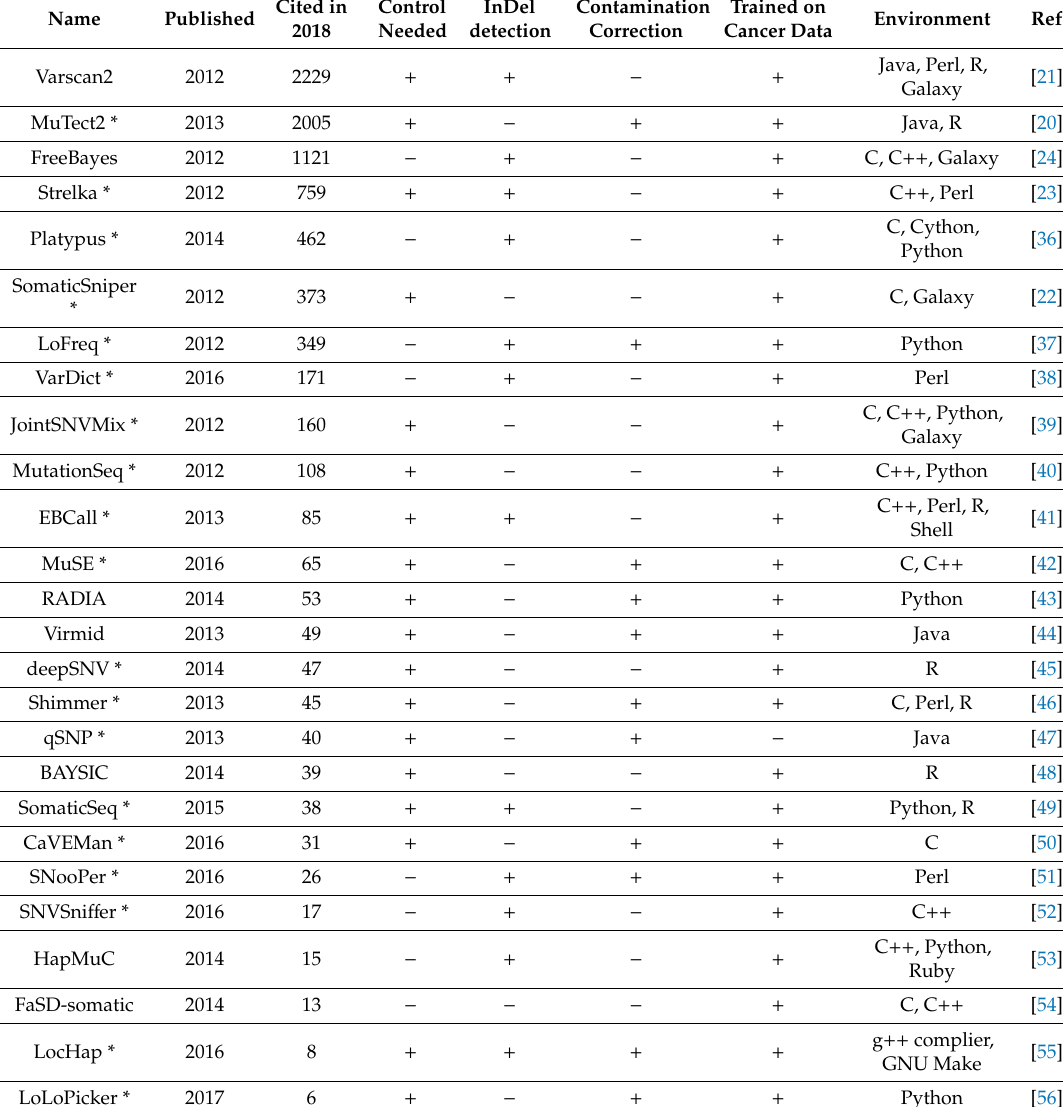
Table 1. Bioinformatic methods available for single nucleotide variant calling. Tools marked with an asterisk (*) are suitable for both whole genome sequencing (WGS) and whole exome sequencing (WES) data